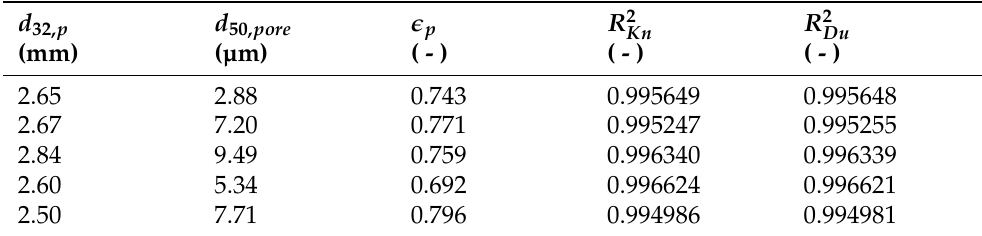
Table 3. Coefficient of determination of the sample moisture evolution over time during freeze- drying, using the Knudsen approach R 2 mental